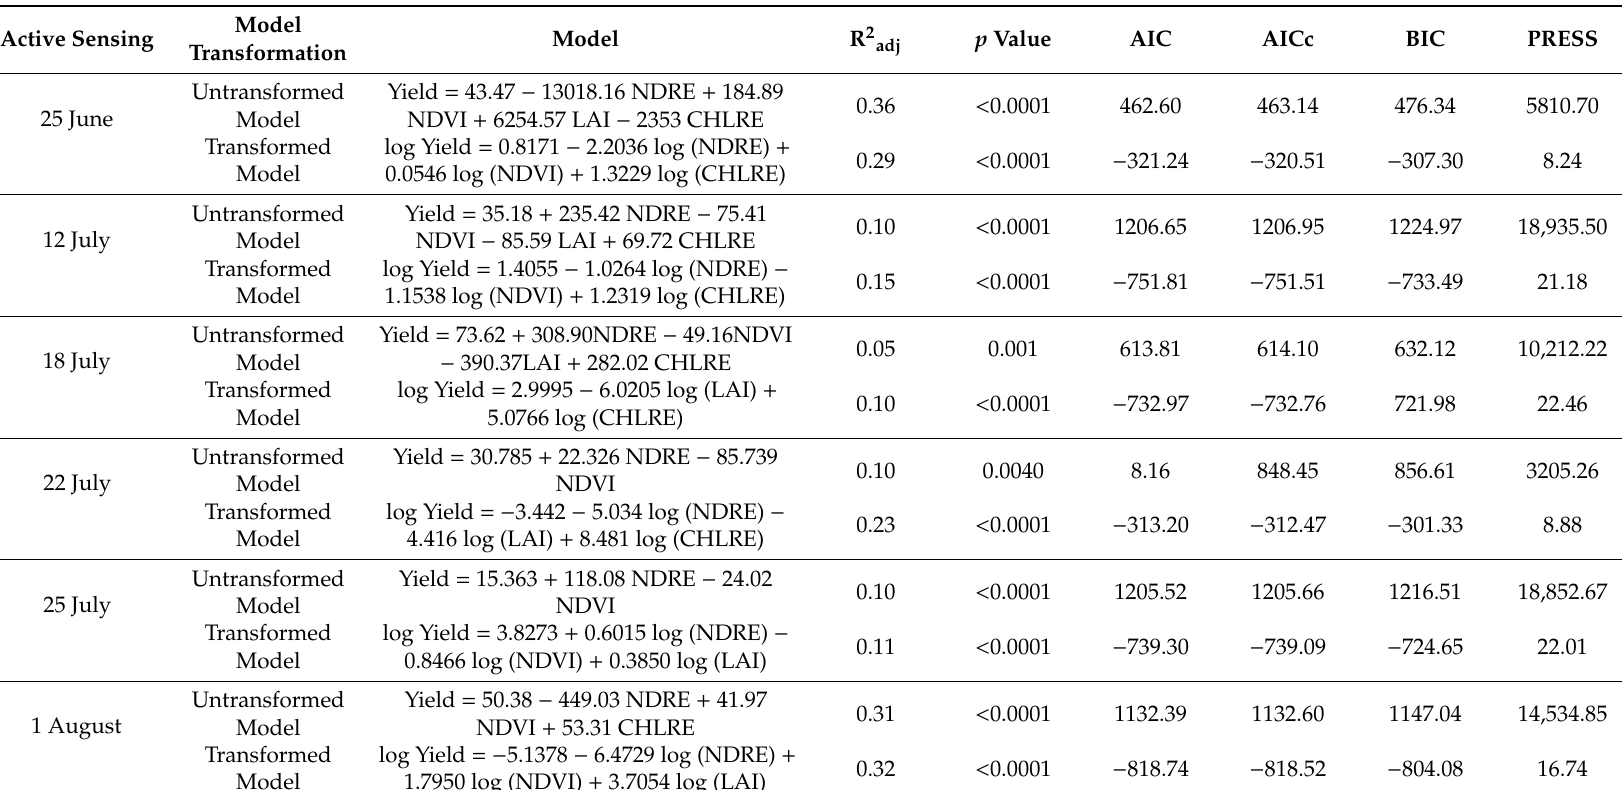
Table 4. Total potato yield models with the adjusted coe ffi cient of determination (R 2 adj ), p Value, AIC, AICc, BIC, and PRESS for Crop Circle ™ .